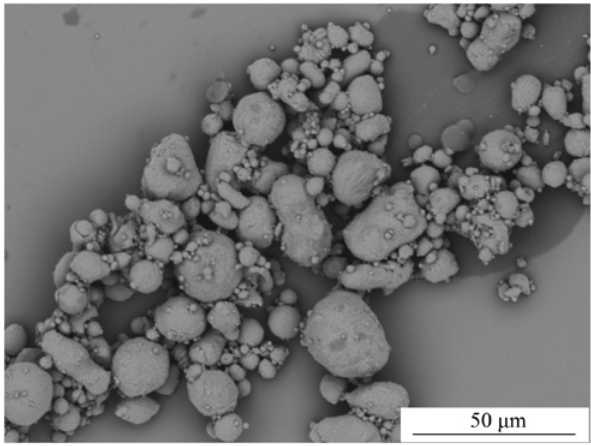
Figure 1: Scanning electron microscopy micrograph of as-received copper